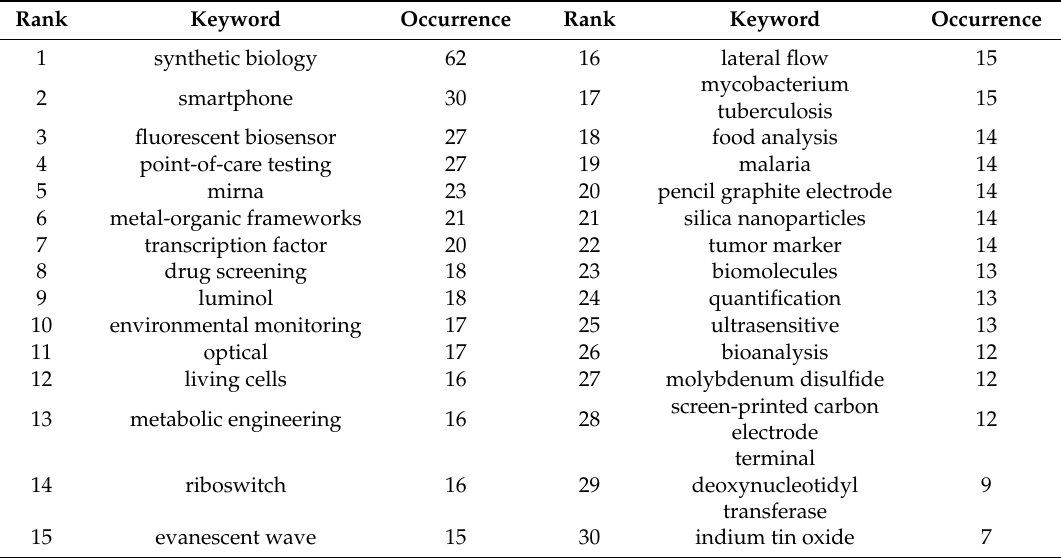
Table 9. The top 30 Terms with more recent ‘average publication years’ included in Figure 14.